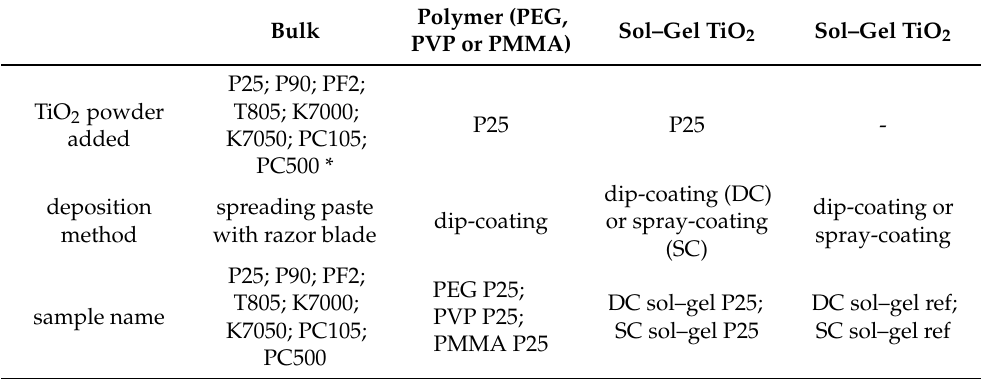
Table 1. Overview of the prepared samples on Al